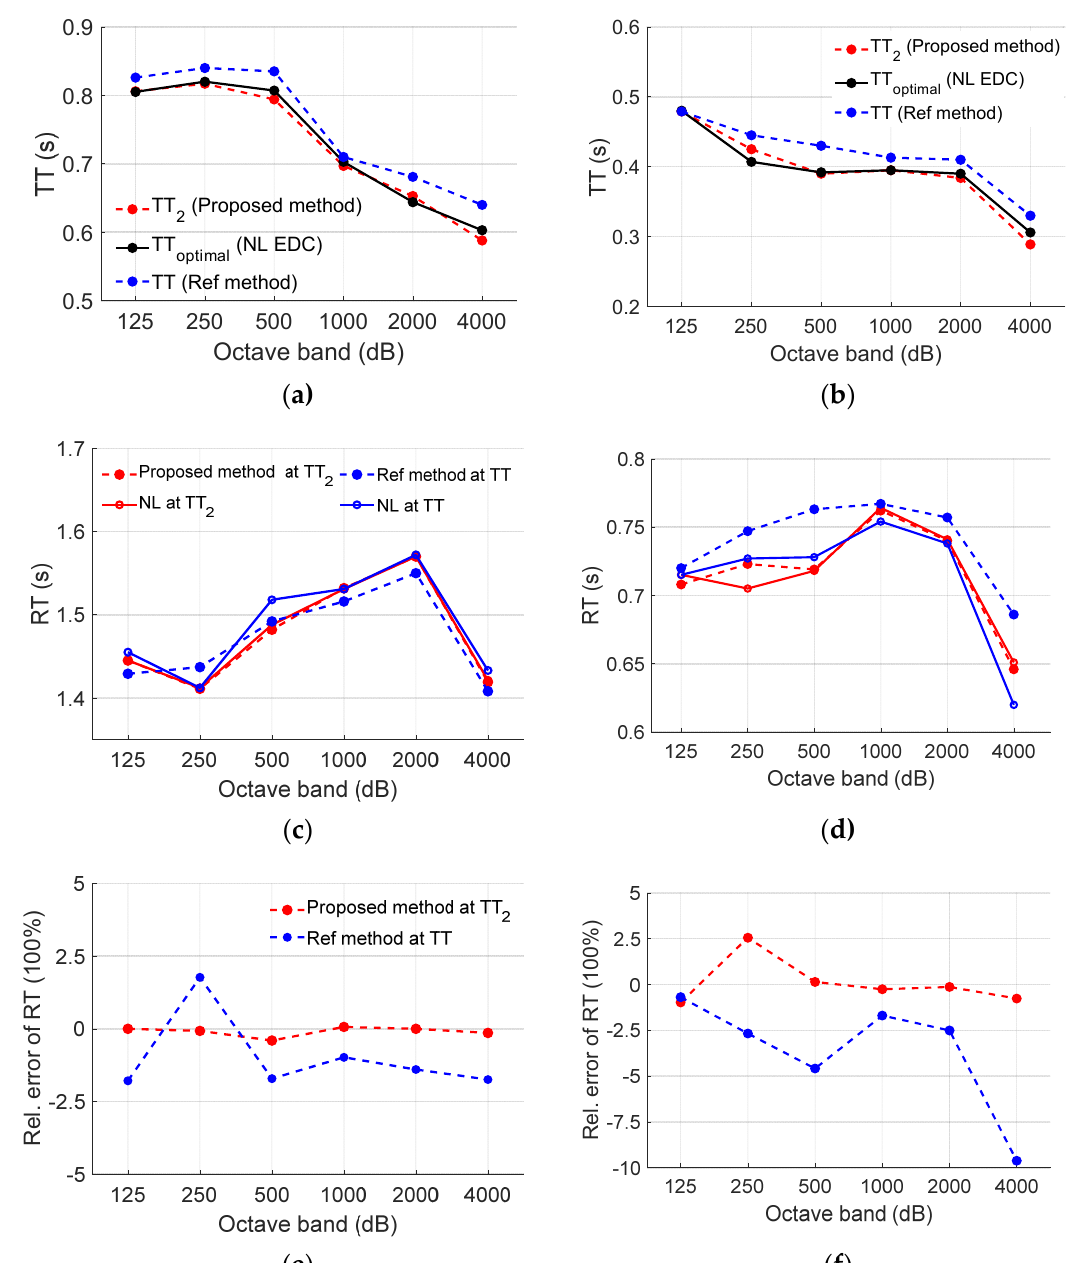
Figure 8. Comparison of the proposed procedure and the compensation method for the RIR measured with ambient noise in two rooms and filtered in octave bands: ( a ) and ( b ) Comparison of the optimal TT of the NL EDC to the TT 2 detected from the proposed method and the TT detected from the reference method. ( c ) and ( d ) Comparison of the corresponding RTs estimated at the TT 2 and the TT located at the truncated EDCs and NL EDC. ( e ) and ( f ) Relative errors of the RTs.